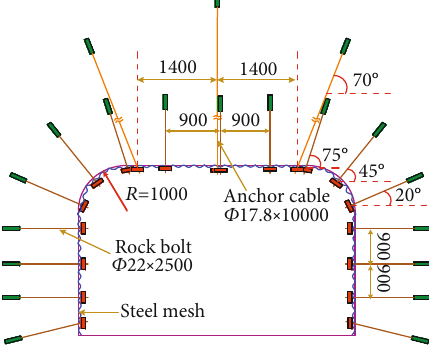
Figure 12: Improved roadway support